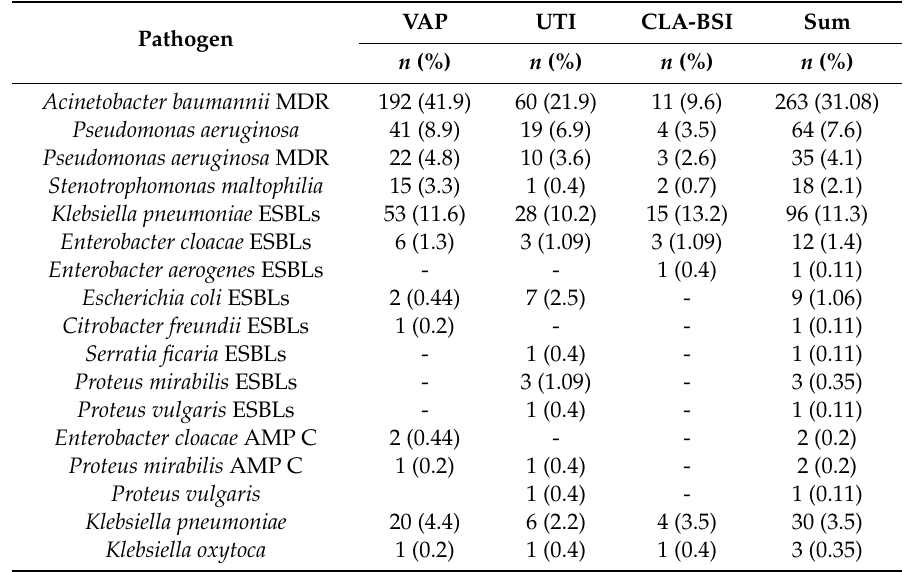
Table 1. Etiological factors of hospital-acquired infections and their location in the years 2011–2018. The data were presented as the number of isolated strains and percentage of the overall number of isolated